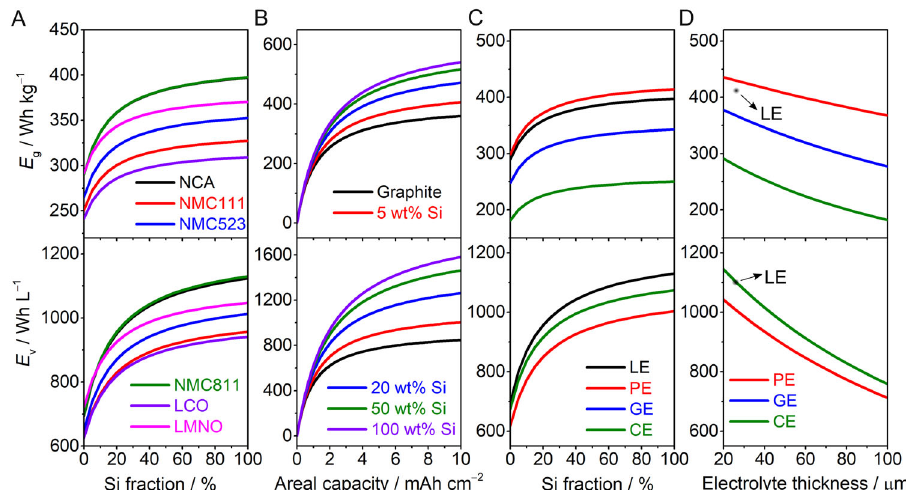
Fig. 4 Estimated speci fi c energy (Eg) and energy density (Ev) values of Si/Si-B/Si-D||IC cells at 25 °C. A Speci fi c energy and energy density vs. Si fraction for LE-based cells at a fi xed areal capacity of 3 mAh cm − 2 . B Speci fi c energy and energy density vs. areal capacity for LE-based cells at various Si contents. C Speci fi c energy and energy density for Si||NMC811 cells using various kinds of electrolytes at a fi xed areal capacity of 3 mAh cm − 2 . D Effect of electrolyte thickness on the speci fi c energy and energy density of Si/Gr (20/80, by wt.)||NMC811 cells at a fi xed capacity of 5 mAh cm − 2 (LE